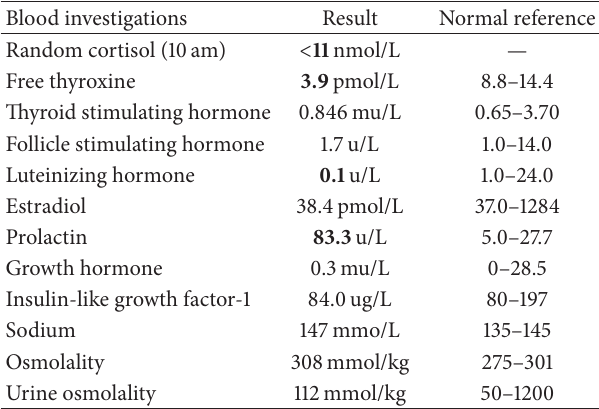
Table1:Baselinelaboratoryresultsshowingpresenceofpanhypopi- tuitarism, hyperprolactinemia, and diabetes